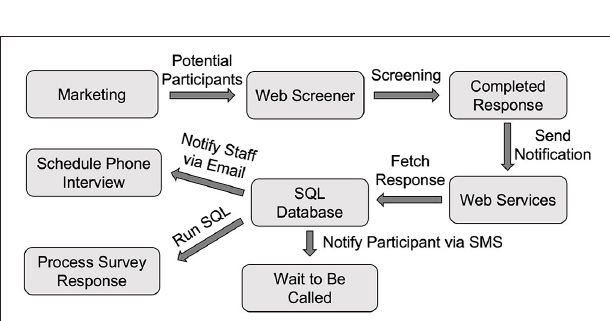
FIGURE 2 | The Workflow of initial screening using Qualtrics. SQL, Structured Query